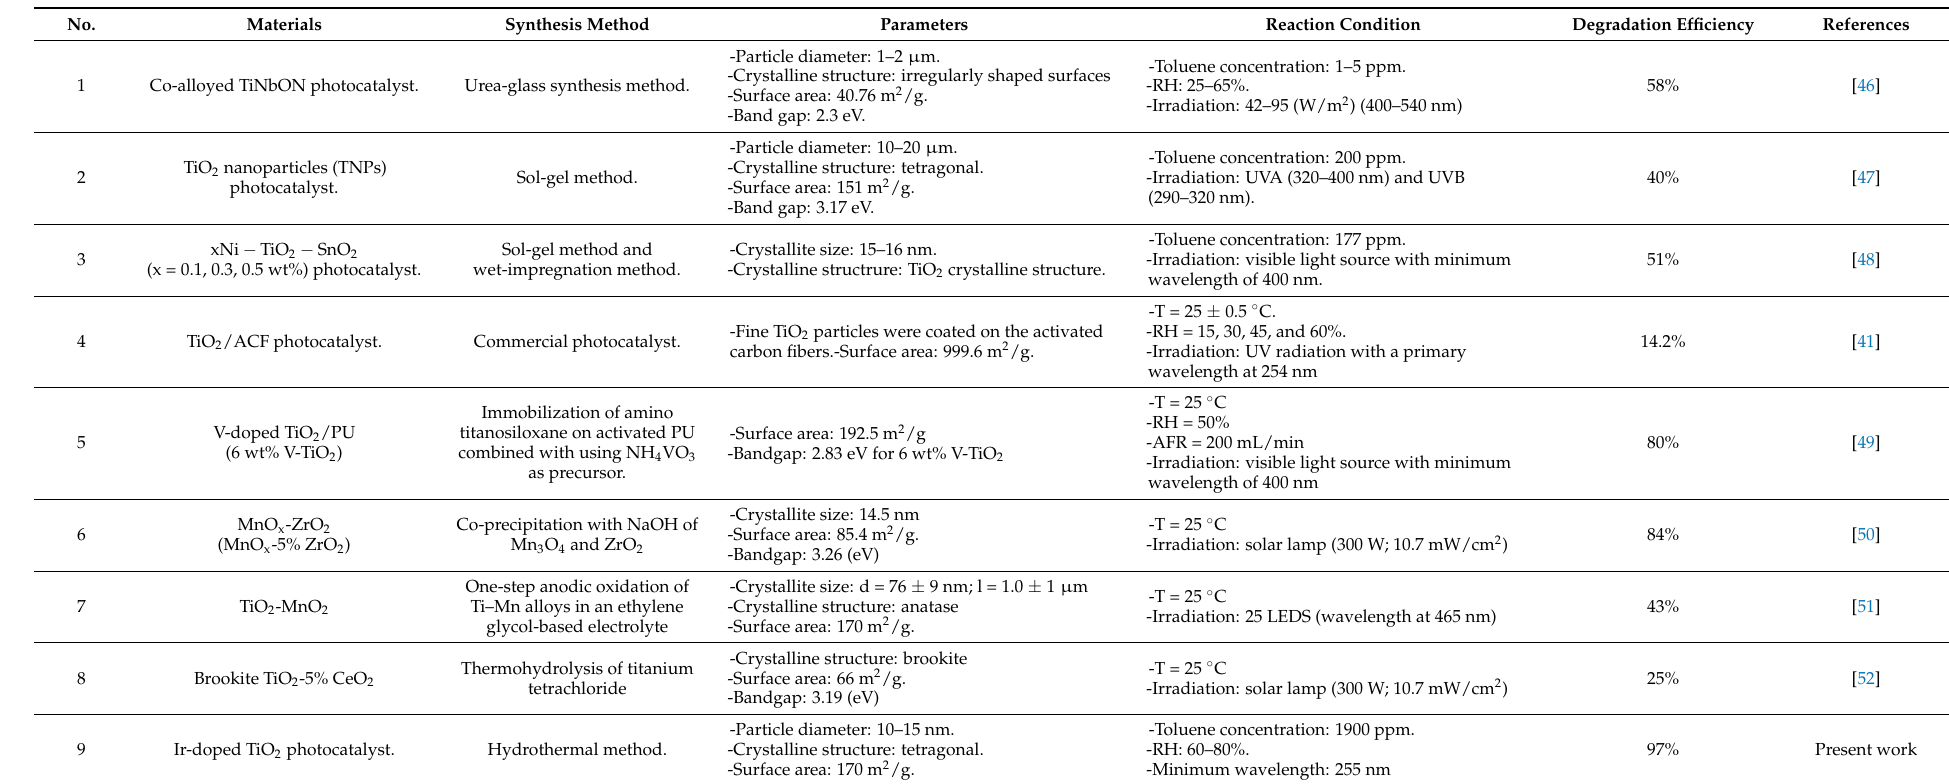
Table 4. The comparison of Ir-doped TiO 2 photocatalyst with previously studied TiO 2 -based